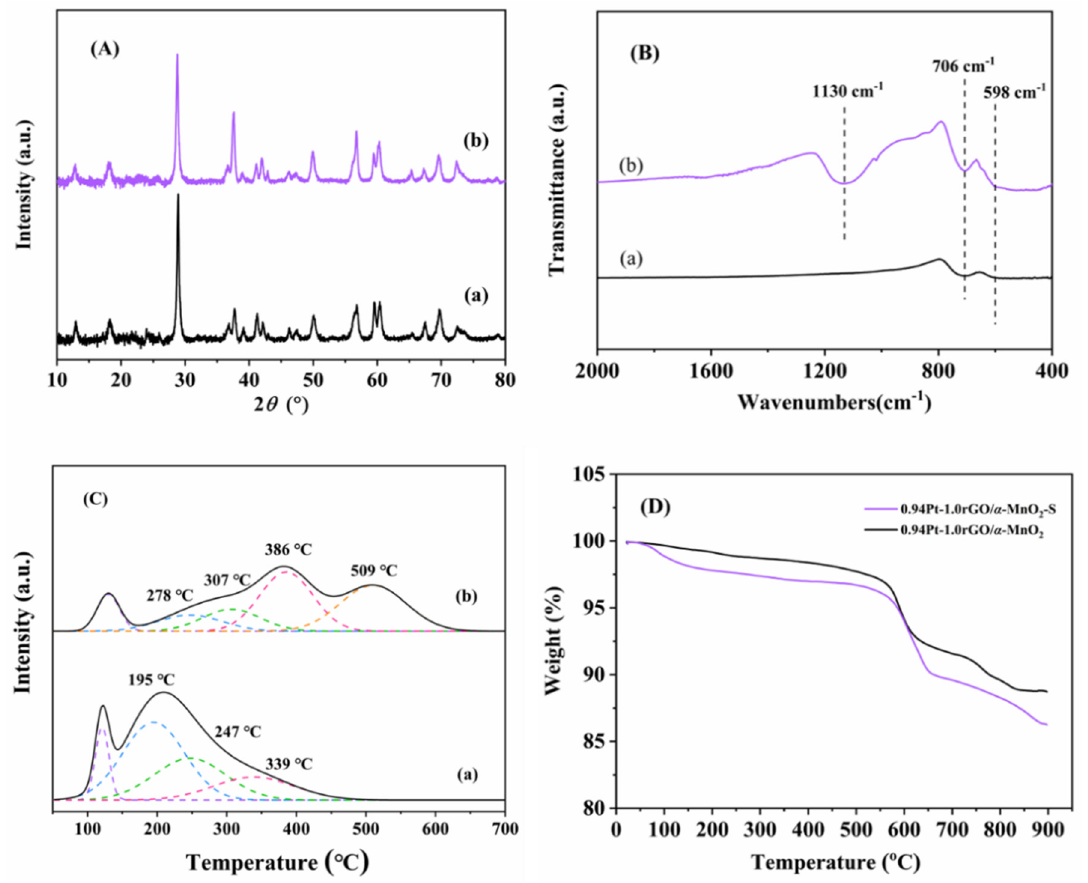
Figure 9. ( A ) XRD patterns, ( B ) FTIR spectra, ( C ) H 2 -TPR profiles, and ( D ) TG profiles of (a) 0.94Pt-1.0rGO/ α -MnO 2 and (b) 0.94Pt-1.0rGO/ α -MnO 2 -S.